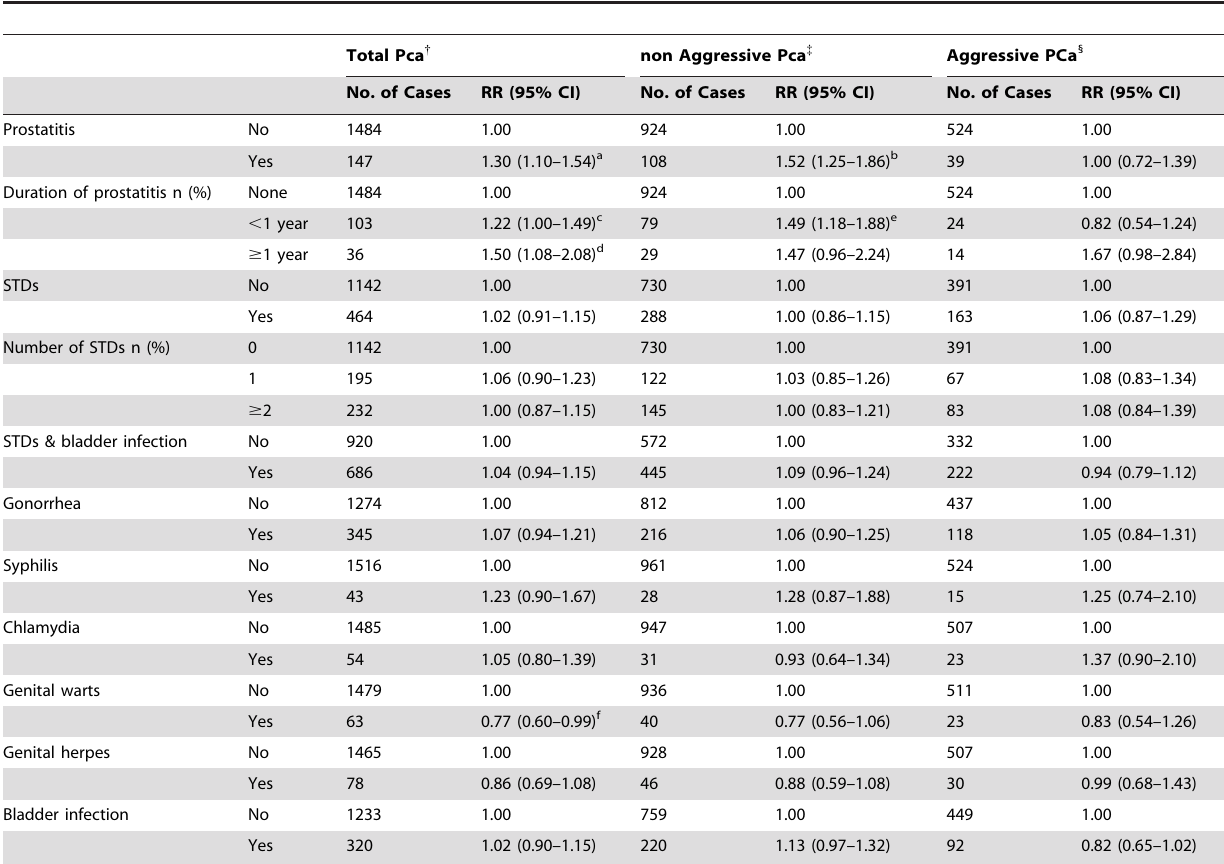
Table 3. Multivariate relative risks and 95% CIs of prostate cancer associated with prostatitis and STD history by severity of disease, California Men’s Health Study, 2002–2006*.